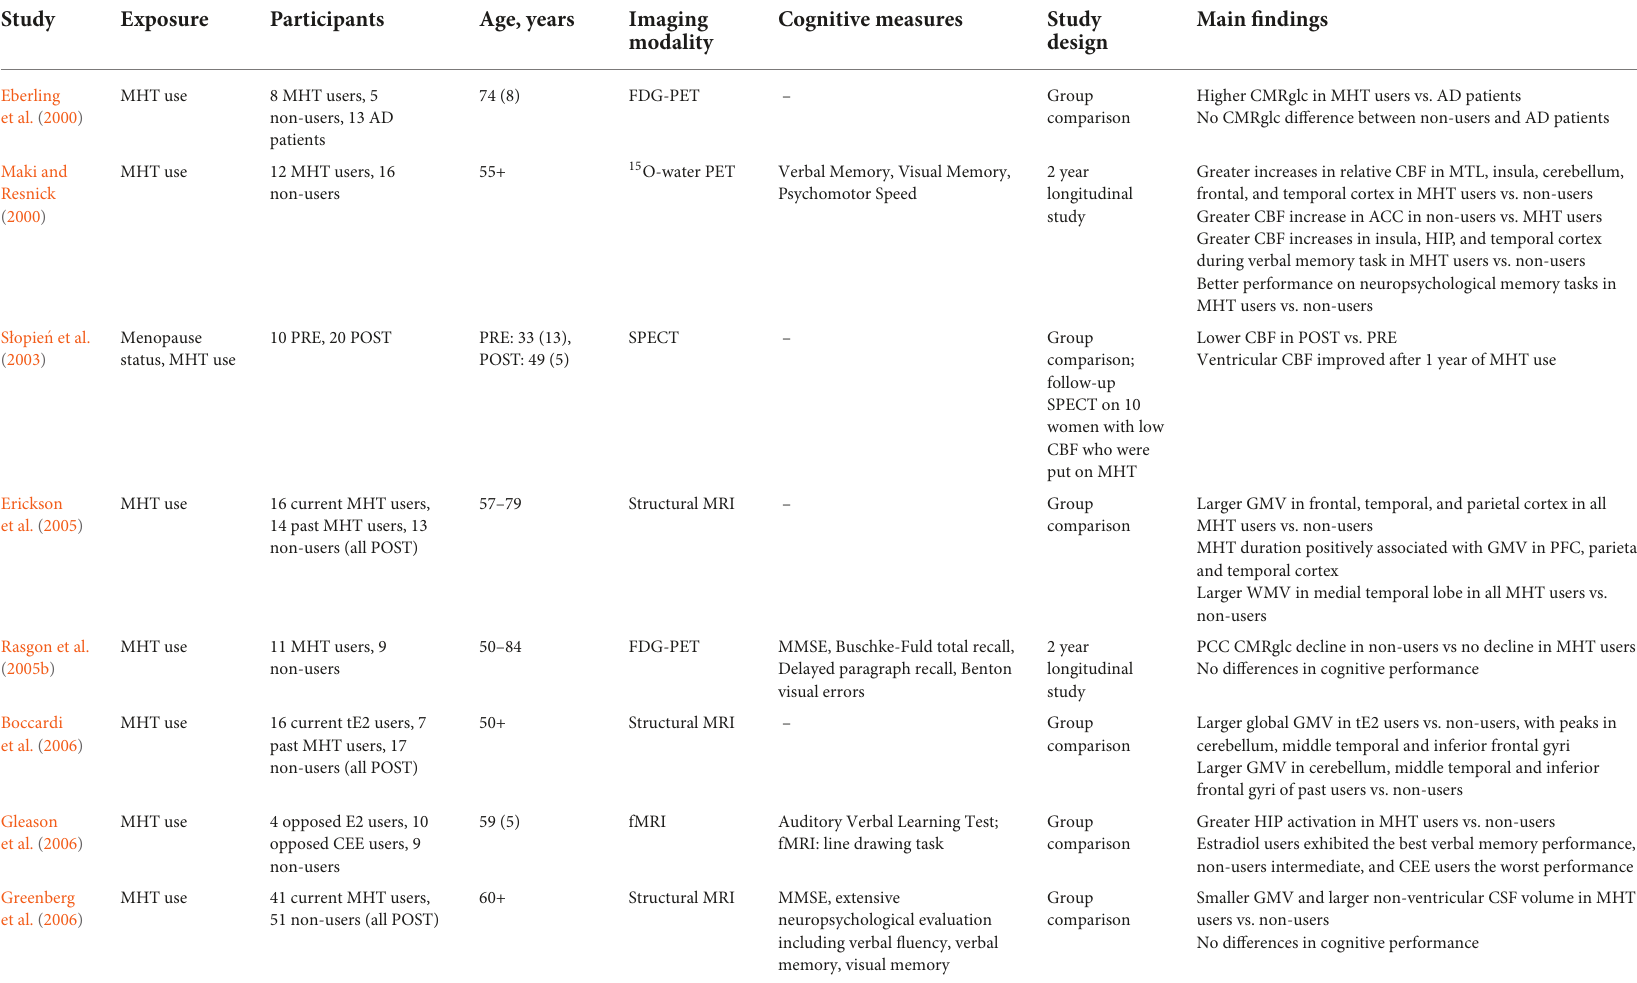
TABLE 2 Observational studies of menopause status and menopausal hormone therapy (MHT) use on neuroimaging